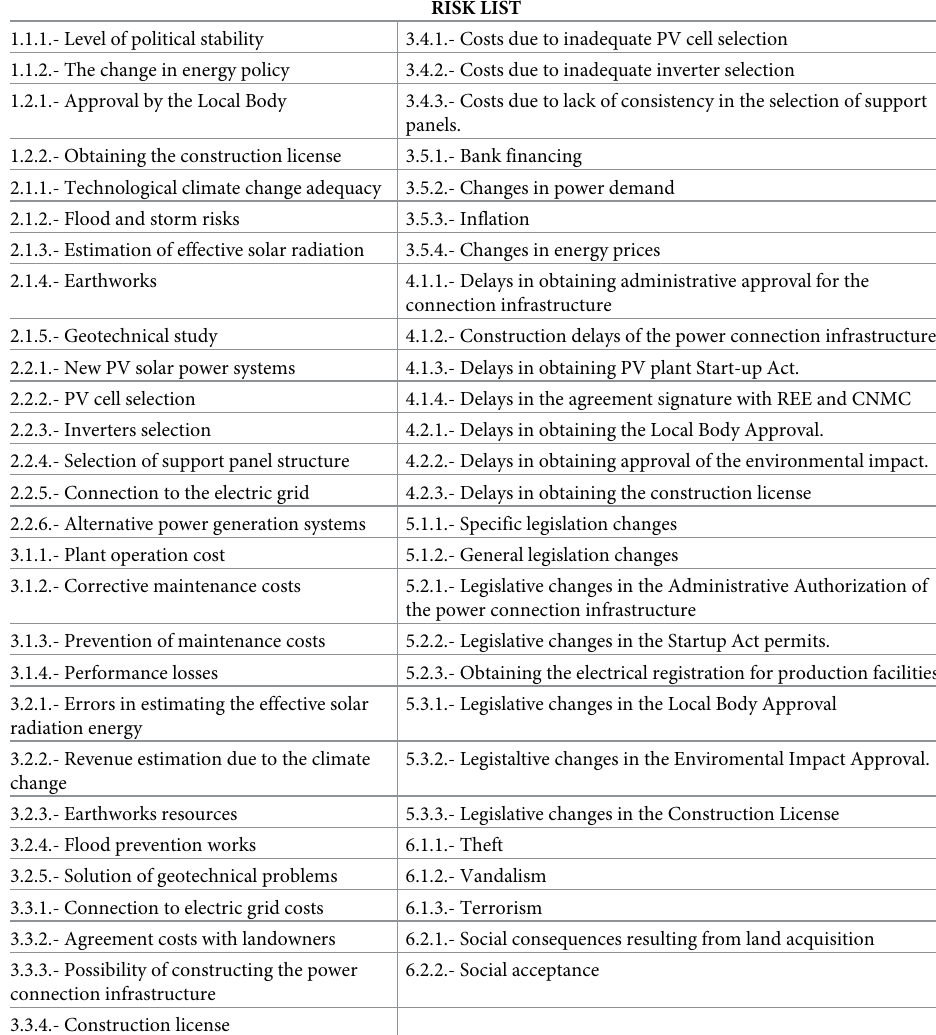
Table 1. Third level at RBS: Project risks